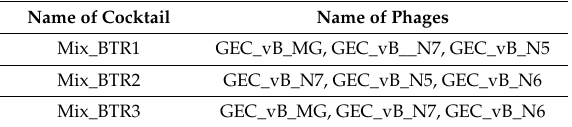
Table 2. Composition of the phage cocktails.